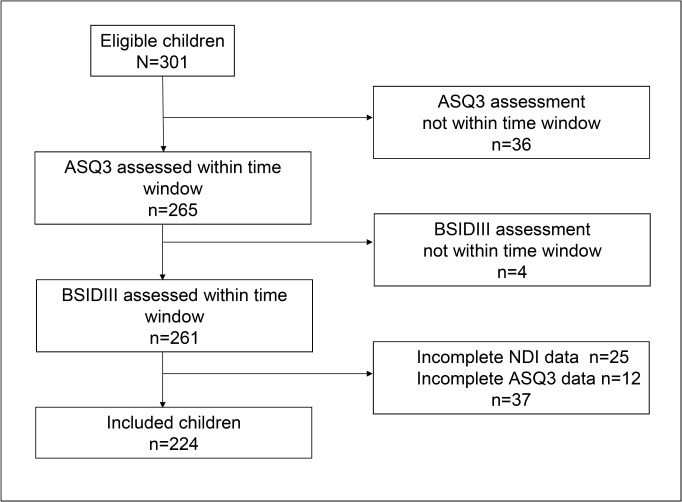
Flowchart with numbers of eligible and included children.ASQ3; Ages and Stages Questionnaire, Third Edition, time window 22–26 months corrected age. BSIDIII: Bayley Scales of Infant and Toddler Development, Third Edition, time window 21–30 months corrected age. NDI: Neurodevelopmental Impairment: BSIDIII cognitive score or composite motor score <70, bilateral blindness/deafness or cerebral palsy.